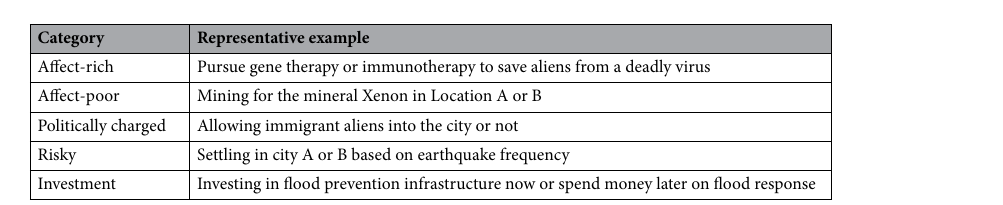
Figure 3. The scenarios in both tasks are worded very closely. The key difference lies in the task: after gathering information by clicking the button, participants either choose one of two options (left), or estimate how much better one option is than the other (right; the scale ranges from − 2.5 to + 2.5 SD of the true information distribution).